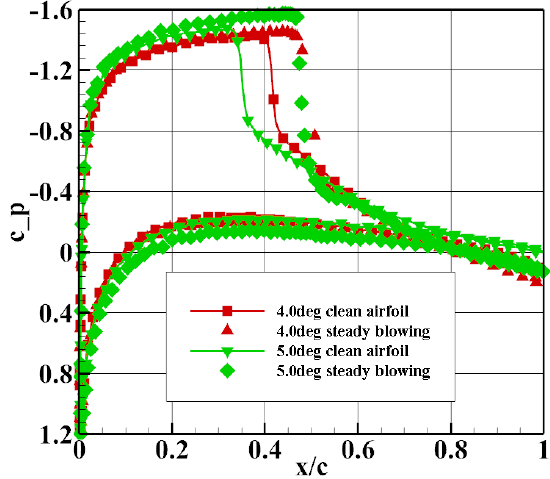
Figure 7. Surface pressure distribution with/without blowing .